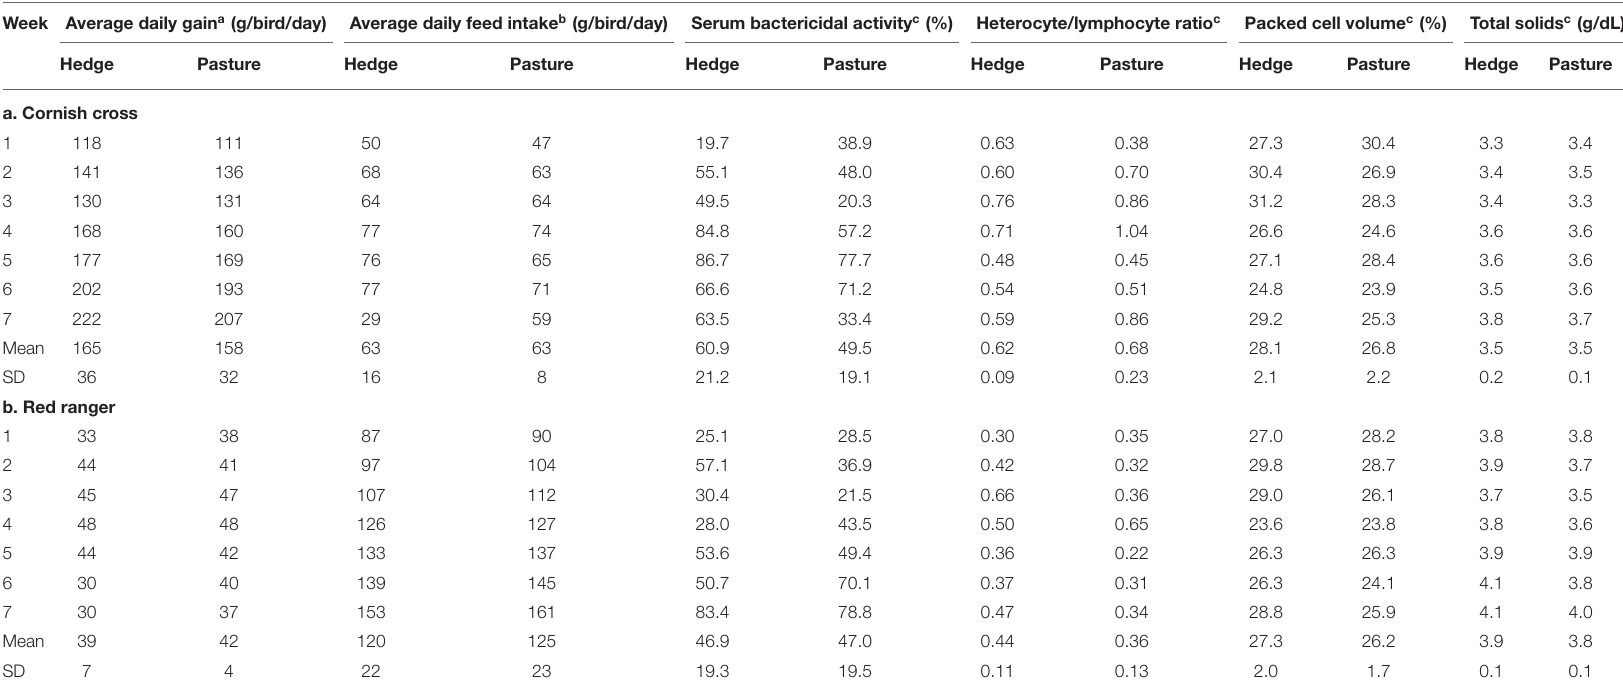
TABLE 2 | Means and standard deviations for all response variables by treatment during each week of the finisher phase (30–76 days of age) for both the Cornish cross (A) and the Red ranger